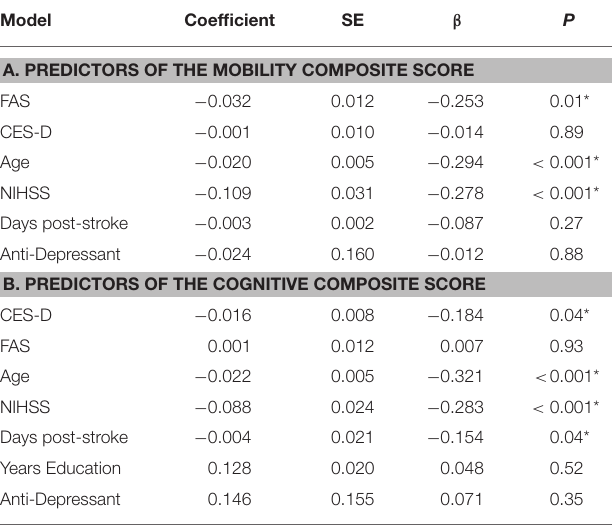
TABLE 2 | Model results for (A) mobility and (B) cognitive outcomes.